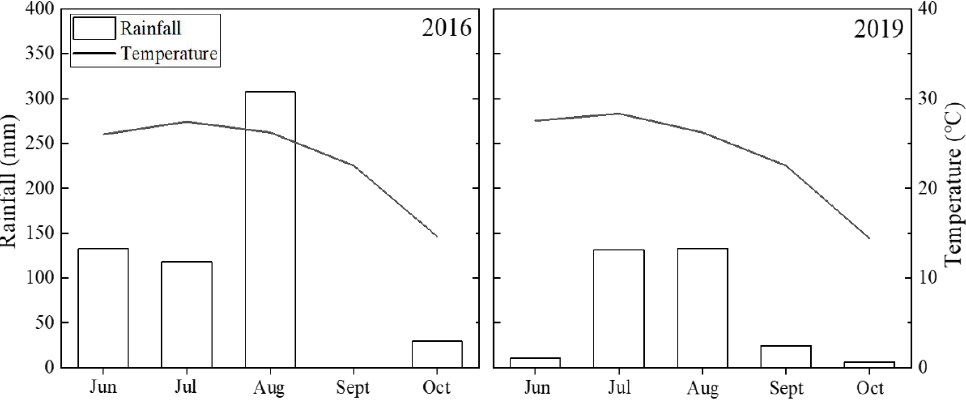
Figure 1. Average monthly rainfall and temperature during maize growing season (Jun 1 to Oct 31) in 2016 and